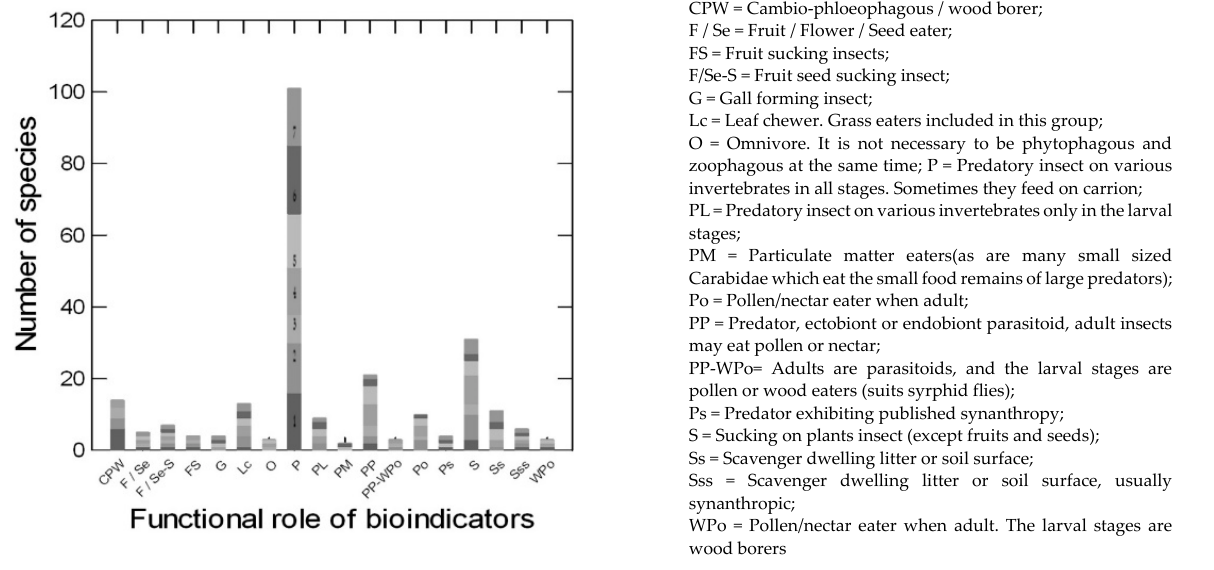
Figure 2. Diagram showing the number of species in each out of 18 functional roles. The numbered strands of the highest bar corresponding to the functional role of predators correspond to each of the seven habitat types. The lateral text box explains the symbols of the functional roles.